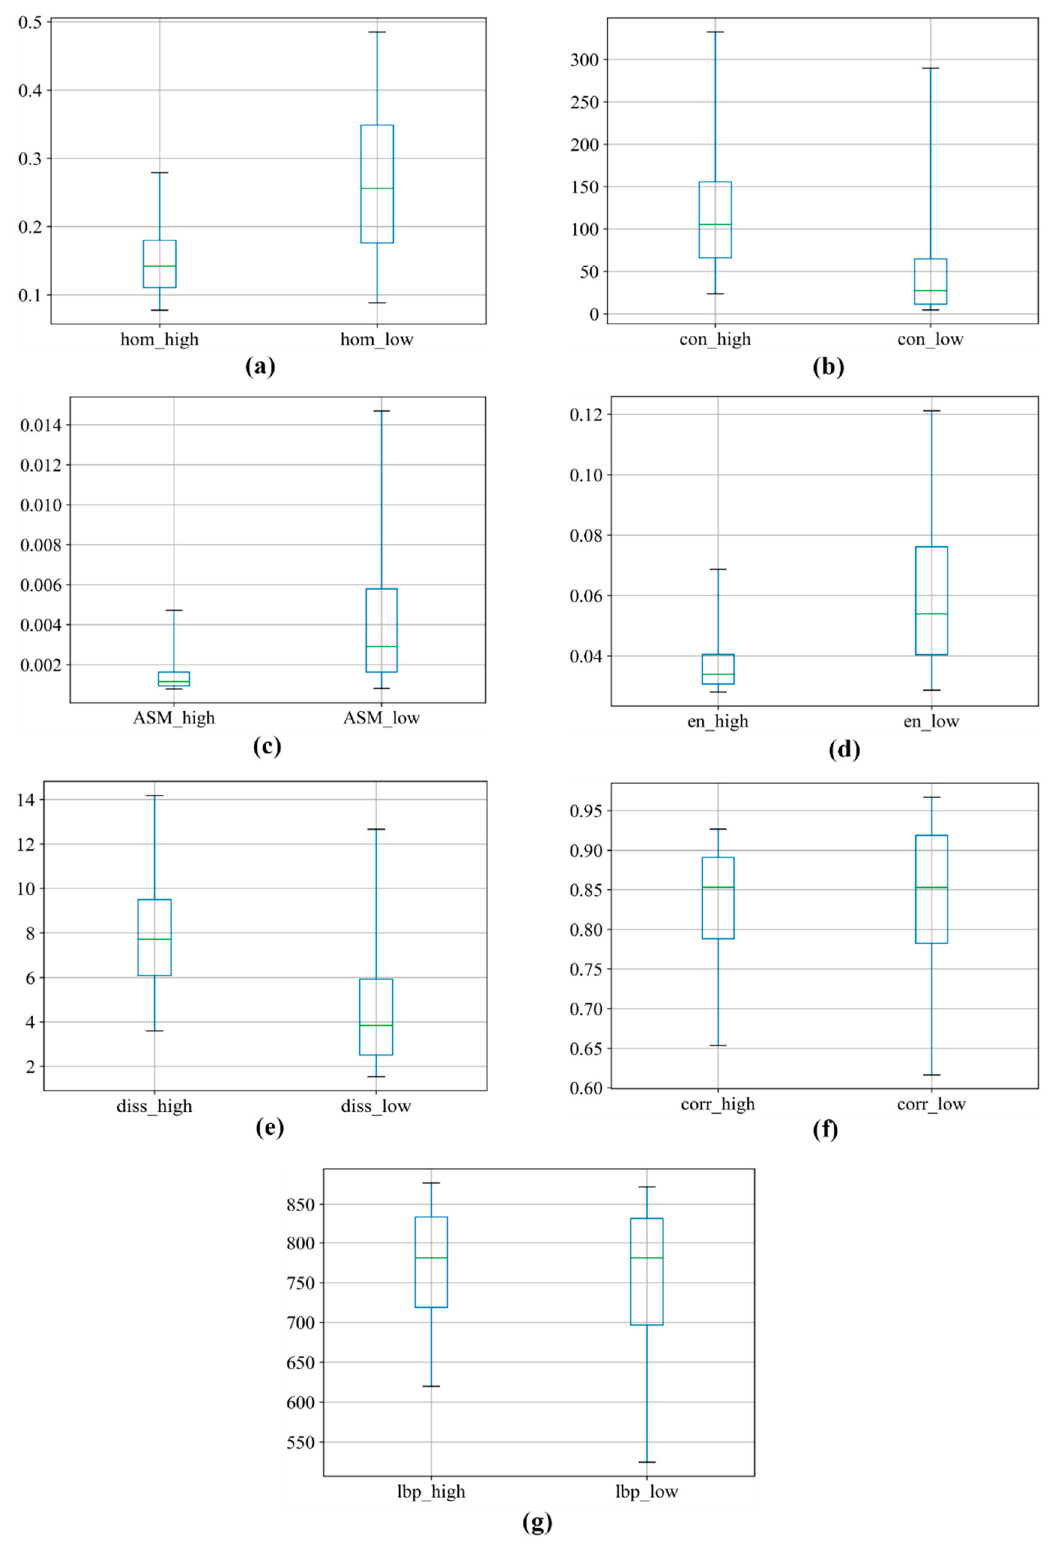
Figure 6. Comparison of the high- and low-density vegetation patches for GLCM texture features where ( a ) is the homogeneity, ( b ) is the contrast, ( c ) is the angular second moment (ASM), ( d ) is the energy, ( e ) is the dissimilarity, ( f ) is the correlation, and ( g ) is the LBP.